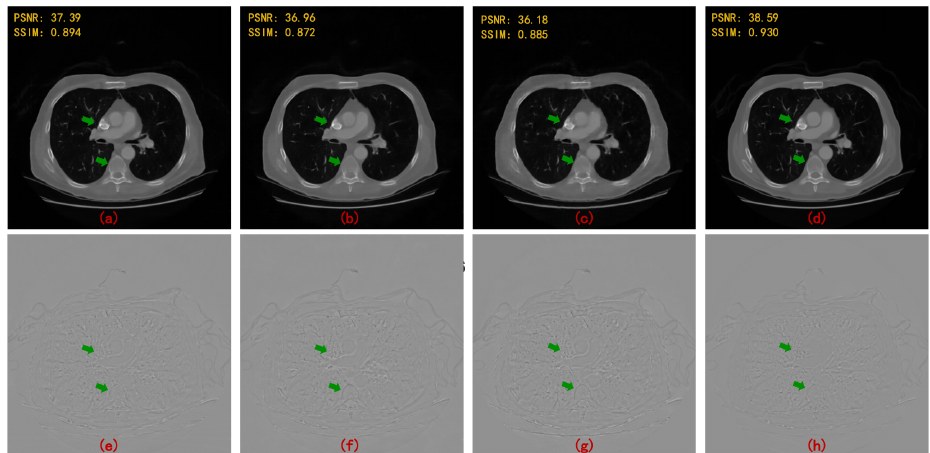
Figure 7. Reconstruction results and corresponding error maps of different post-processing methods at four angular intervals (90 views). ( a ) FBPConvNet; ( b ) RED-CNN; ( c ) DD-Net; ( d ) MWCNN; ( e ) error map of ( a ); ( f ) error map of ( b ); ( g ) error map of ( c ); and ( h ) error map of ( d ).